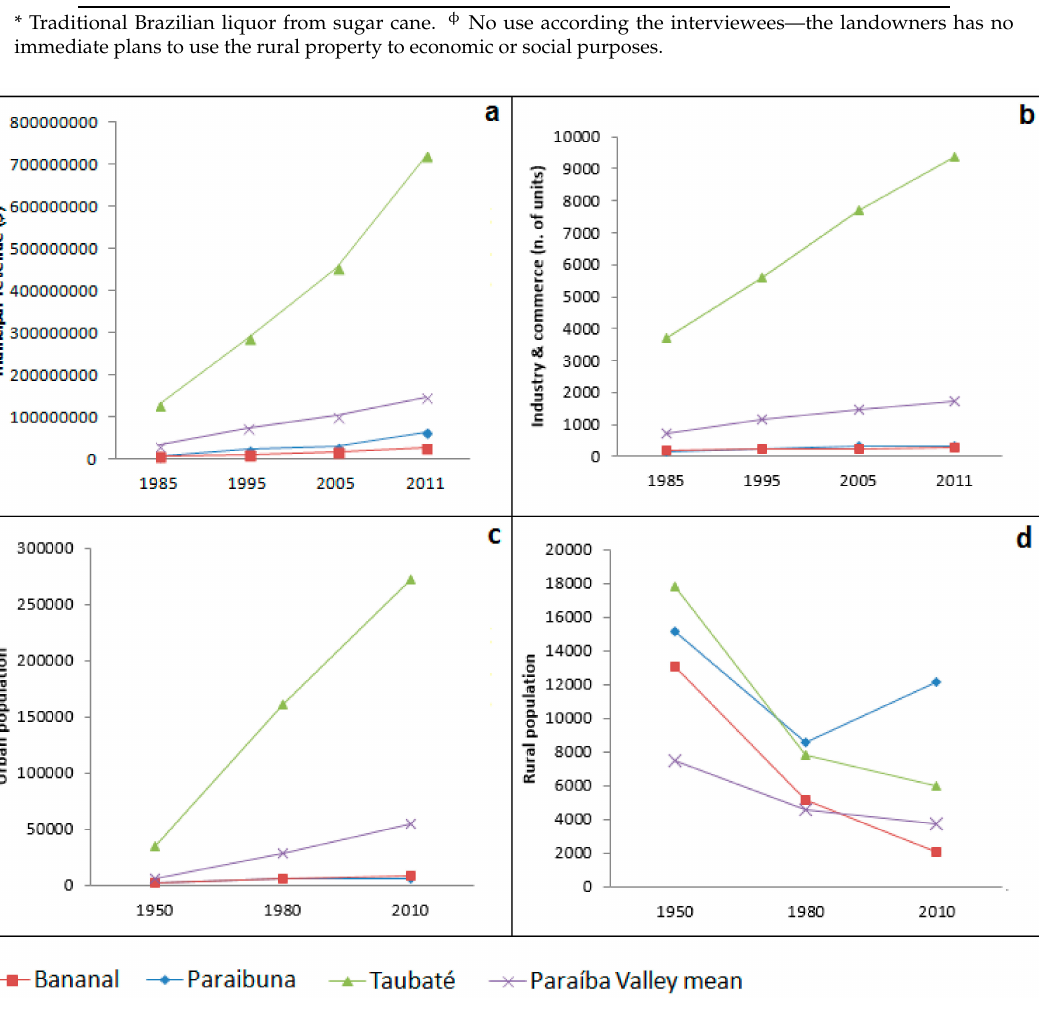
Figure 3. Selected socioeconomic data for the surveyed municipalities in the Para í ba